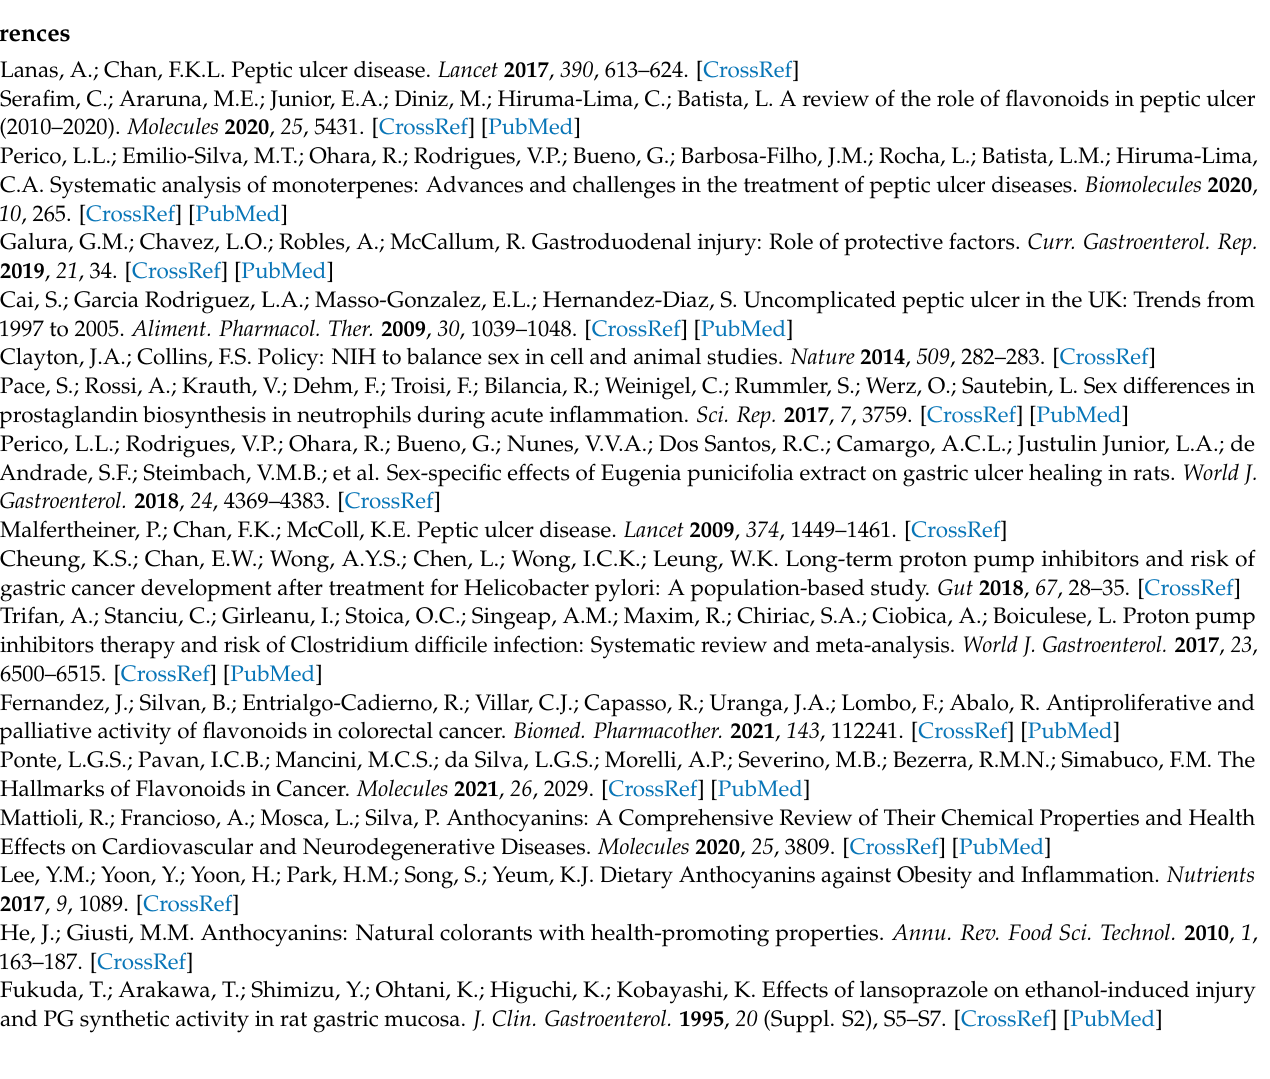
Table S7: Details of Catalase (CAT) binding site mapping; Table S8: Major molecular interactions detected in the protein (GSH); Table S9: Mapping details of Glutathione reductase (GSH) binding sites; Table S10: Main molecular interactions detected in the Myeloperoxidase (MPO) protein; Table S11: Mapping details of Myeloperoxidase (MPO) binding